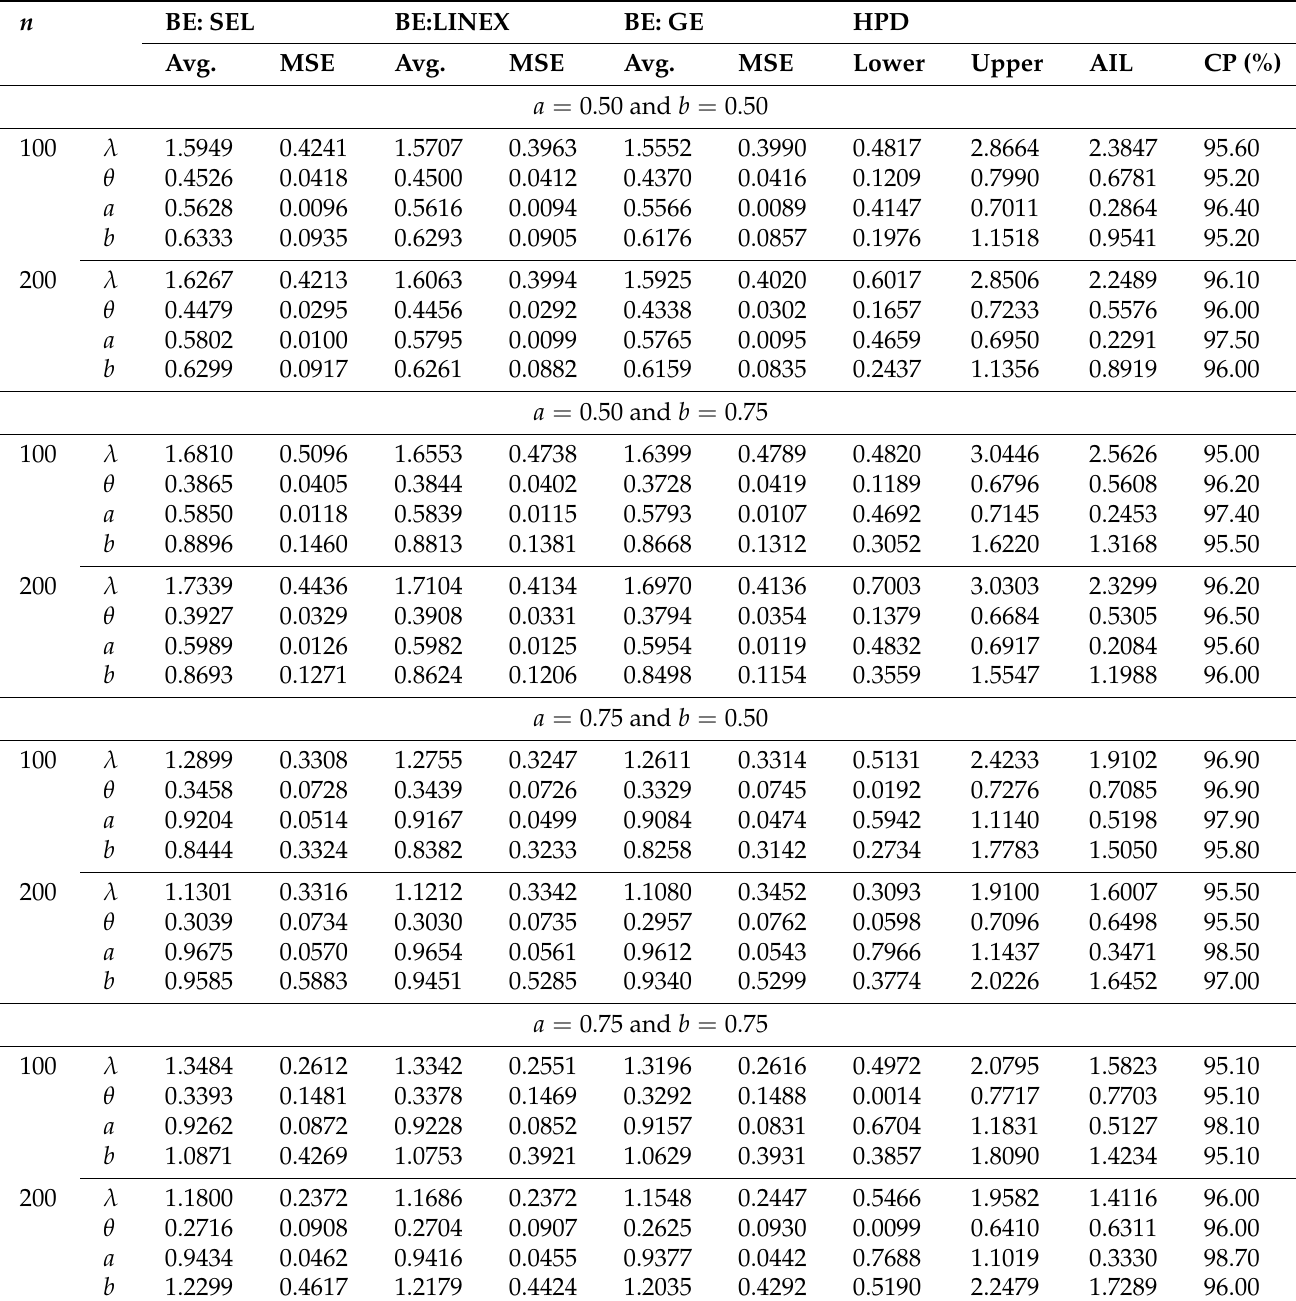
Table 12. Avg. estimated values and MSEs of the BE using MCMC for the BBE 2 distribution